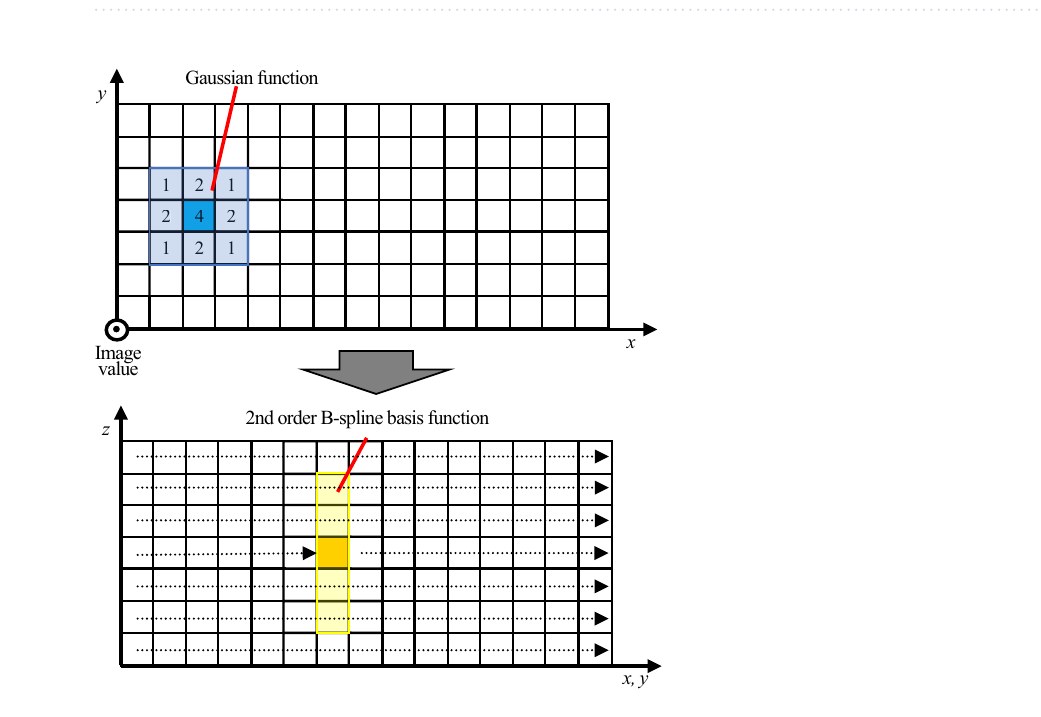
Figure 3. Gaussian function and 2nd order B-spline basis